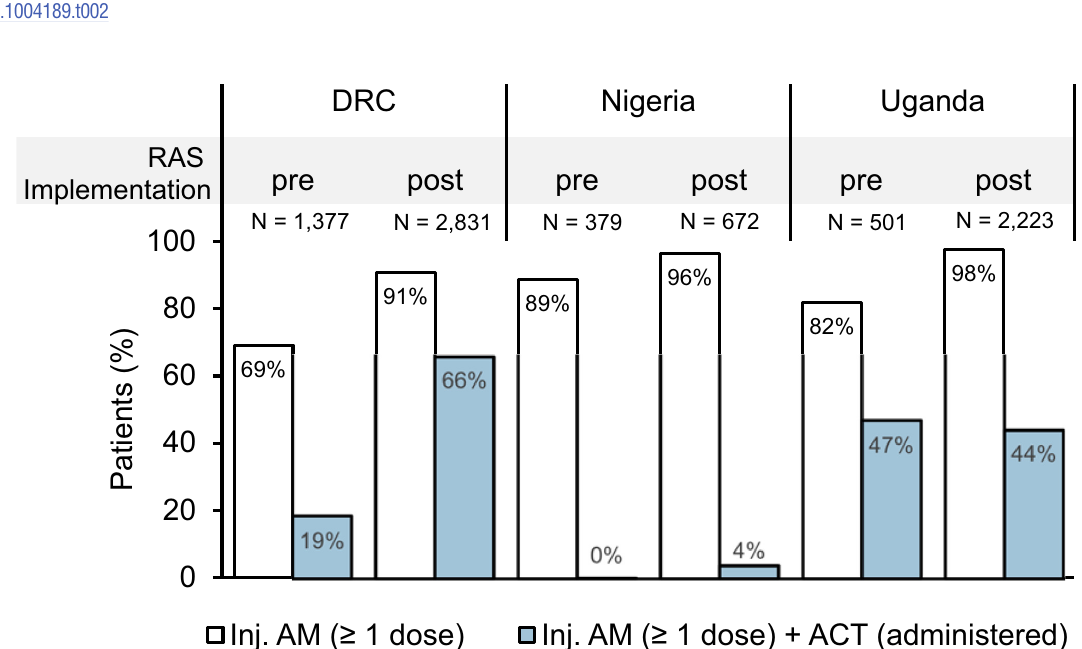
Fig 2. Appropriateness of antimalarial medication provided to children diagnosed with severe malaria before and after the implementation of RAS, by country and by RAS implementation period (%). Treatment of admitted children referred by a community-based provider or directly attending an RHF was assessed before and after the roll-out of RAS (pre vs. post). Proportion of children administered at least 1 dose of an injectable antimalarial (artesunate, artemether, or quinine; white bars) and at least 1 dose of an injectable antimalarial and an in-hospital ACT consisting of either ALU or ASAQ (blue bars). ACT, artemisinin-based combination therapy; ALU, artemether-lumefantrine; AM, antimalarial; ASAQ, artesunate-amodiaquine; DRC, Democratic Republic of the Congo; RAS, rectal